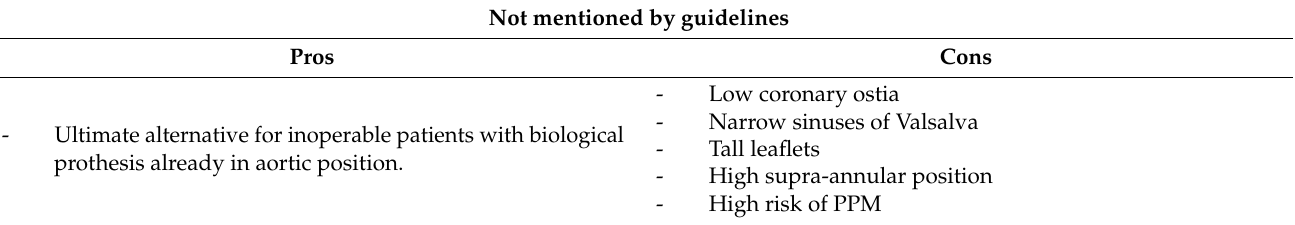
Table 9. Decision Making Algorithm.